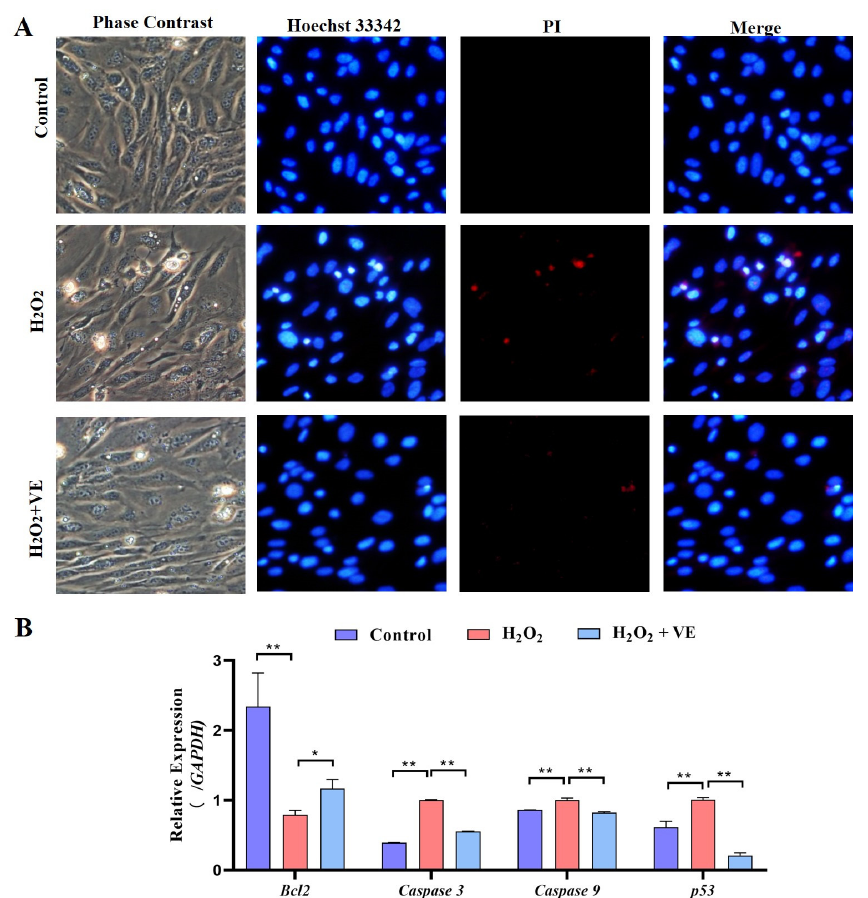
Figure 14. Changes in the levels of apoptosis of VE antioxidants under H 2 O 2 -induced oxidative stress. ( A ) TUNEL assays were performed according to the instructions of the Promega Dead-end™ Fluorometric TUNEL system kit. ( B ) Expression of Bcl-2 , Caspase-3 , Caspase-9 and p53 after treatment with VE under H 2 O 2 -induced oxidative stress ( n = 3). * p < 0.05; ** p <